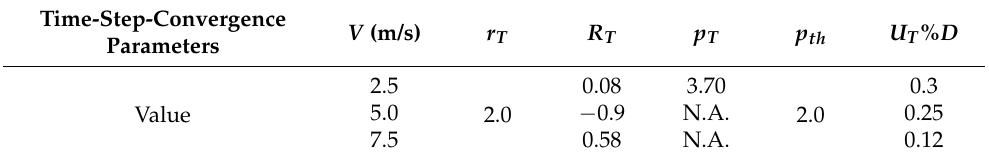
Table 5. Results for time-step-convergence